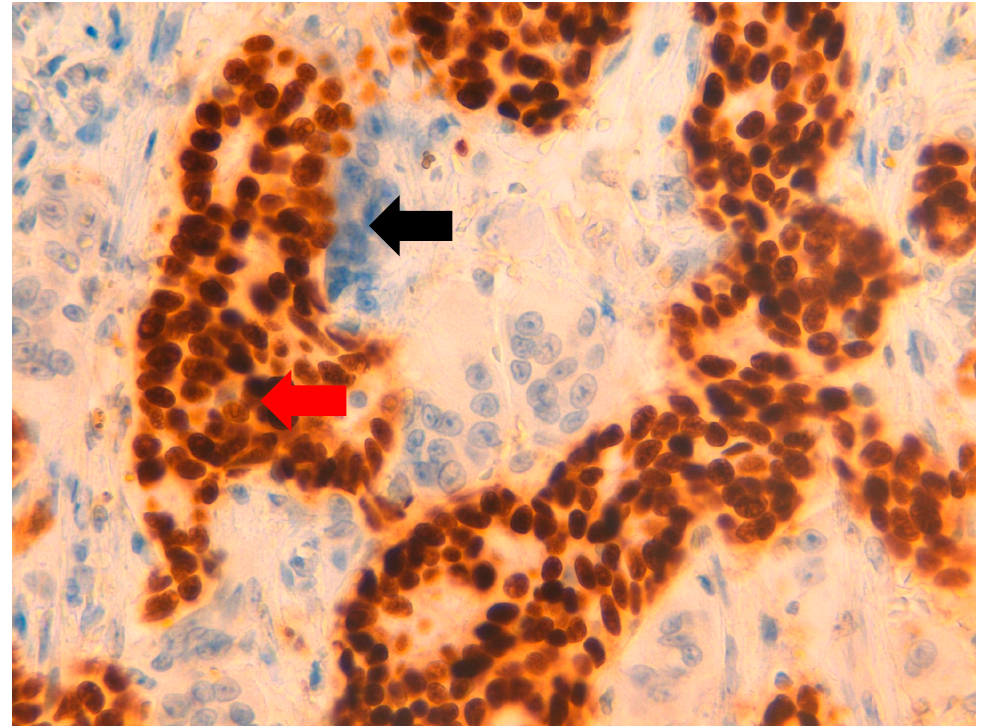
Figure 5. At 40x magnification. Immunohistochemical-positive reaction of neoplastic cells for E-cadherin ( ), unlike Figure 5. At 40 × magnification. Immunohistochemical-positive reaction of neoplastic cells for E-cadherin ( Figure 4. At 40x magnification. Immunohistochemical-positive reaction of OGCs and macrophages for CD163 ( ), unlike Figure 2. Hematoxylin and eosin stain 20x showing invasive ductal carcinoma with at least 30 osteoclast-like giant cells OGCs, which are E-cadherin-negative ( ). J. Pers. Med. 2021 , 11 , 156 OGCs, which are E-cadherin-negative ( ). ( ↑ ), which are multinucleated cells and vary in shape and size with eosinophilic cytoplasm; grouped neoplastic cells ( ) neoplastic cells, which are CD163-negative ( ). are present immersed in the stroma containing adipocytes ( ↑ ).